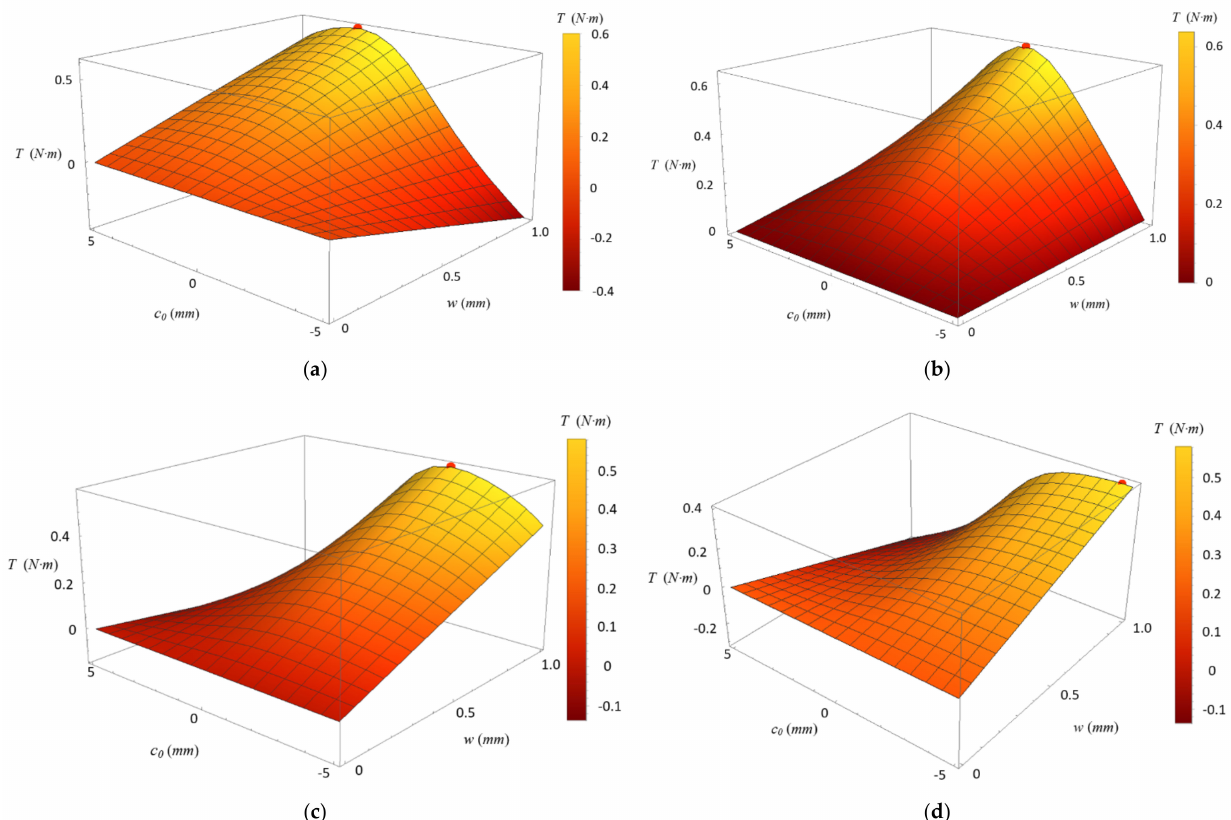
Figure 11. Surface curve of the output torque: ( a ) α = 20 ◦ ; ( b ) α = 40 ◦ ; ( c ) α = 60 ◦ ; and ( d ) α = 80 ◦